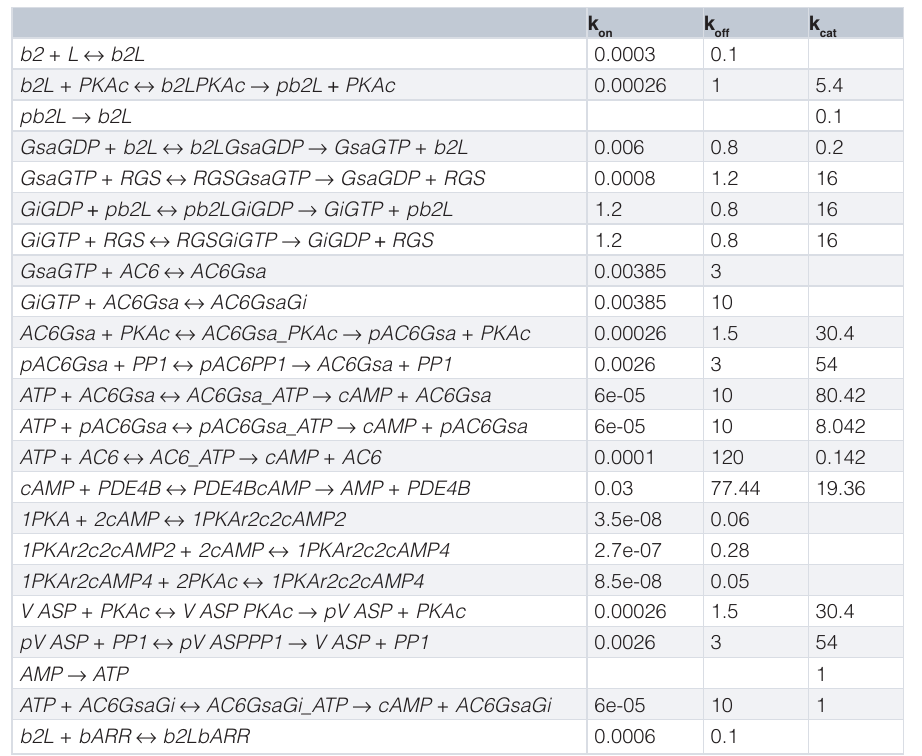
Table 1. Kinetic rates of the sample system, adapted from Sabio-Rk 25 and Brenda 26 , adjusted to experimental cAMP time-series data 11